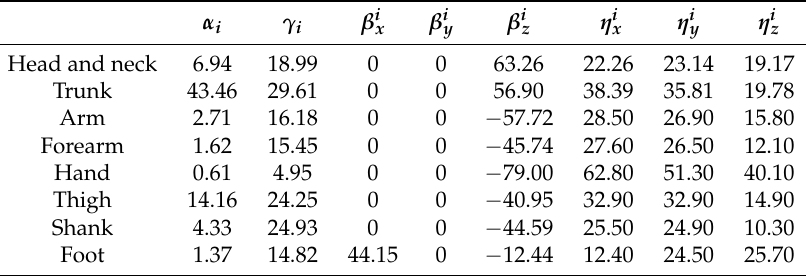
Table A1. Zatsiorsky–DeLeva model parameters for each body